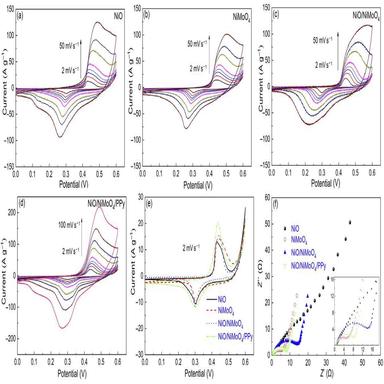
(Color online) Electrochemical kinetic performance of NiO-based composites. Cyclic voltammetry curves at various scanning rate of NiO (a), NiMoO4 (b), NiO@NiMoO4 (c), NiO@NiMoO4@PPy (d), and comparison of all electrodes at a scanning rate of 2 mV s1 (e); (f) Nyquist plots of all electrodes (insets are the enlarged Nyquist plots).